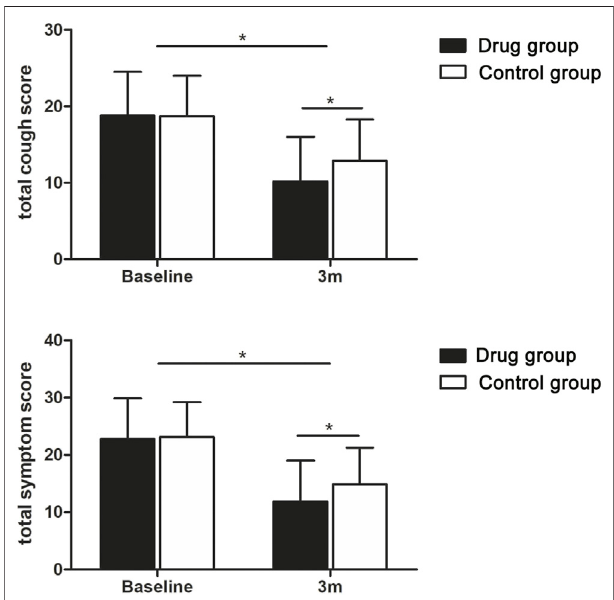
FIGURE2| Tendencychartsofthetotalcoughscoreandtotalsymptom score in the two groups three months after discharge. * p < 0.05.